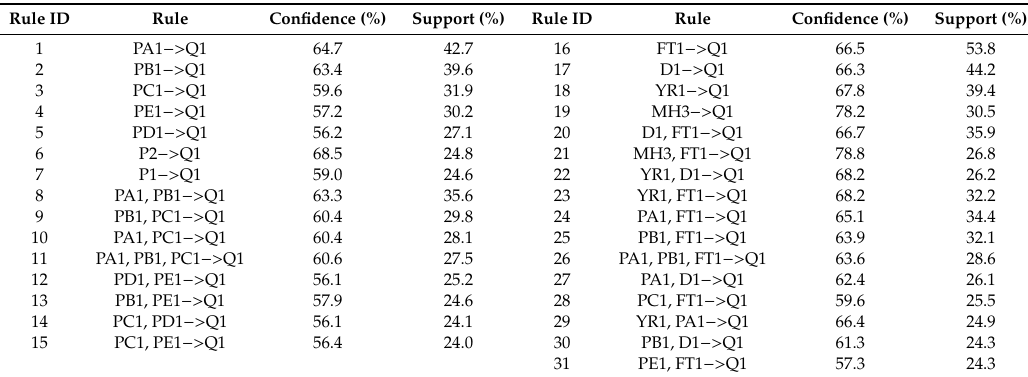
Figure 4. Distribution of association rules. Table 4. Strong association rules mined by association rules.